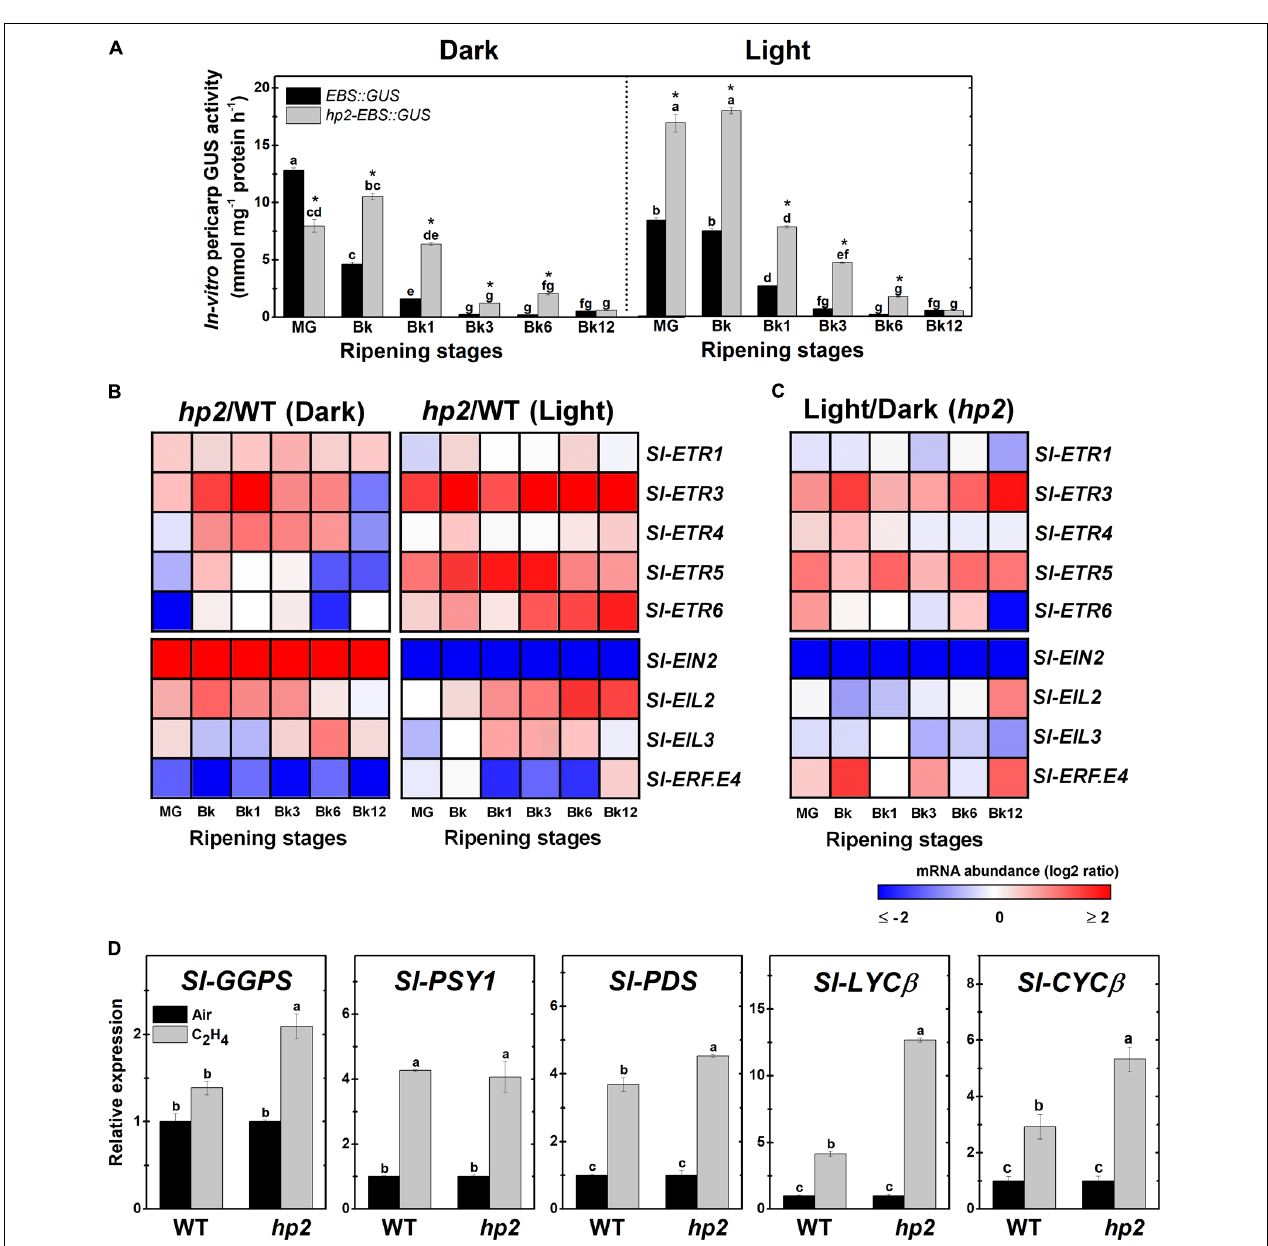
FIGURE 4 | Loss of Sl-DET1/HP2 function promotes ethylene tissue sensitivity and signaling output. Treatment details as described in Figure 1 . (A) In vitro GUS activity assayed in wild-type (WT) and high pigment-2 ( hp2 ) fruits carrying the ethylene-responsive promoter EBS fused to the GUS reporter protein ( EBS::GUS and hp2 - EBS::GUS ). (B) Heatmap representation of the differences in relative mRNA levels of ethylene perception and signaling-related genes between the WT and hp2 fruits ripened under light or dark conditions. (C) Heatmap representation of the differences in relative mRNA levels of ethylene perception and signaling-related genes between light and dark samples of hp2 fruits at each sampling time. The relative transcript values are presented in Supplementary Figure 5 . (D) Relative mRNA levels of tomato genes encoding carotenoid biosynthetic enzymes in WT and hp2 fruits treated with 50 ppm ethylene for 6 h. Data are means ( ± SE) of at least three biological replicates. Different letters indicate statistically significant differences (Tukey’s test, p < 0.05) within each genotype (in A ) or among all data (in C ). In A, asterisks indicate statistically significant differences (Student’s t -test, p < 0.05) between genotypes. MG, mature green; Bk, Breaker; ETR, ethylene response;